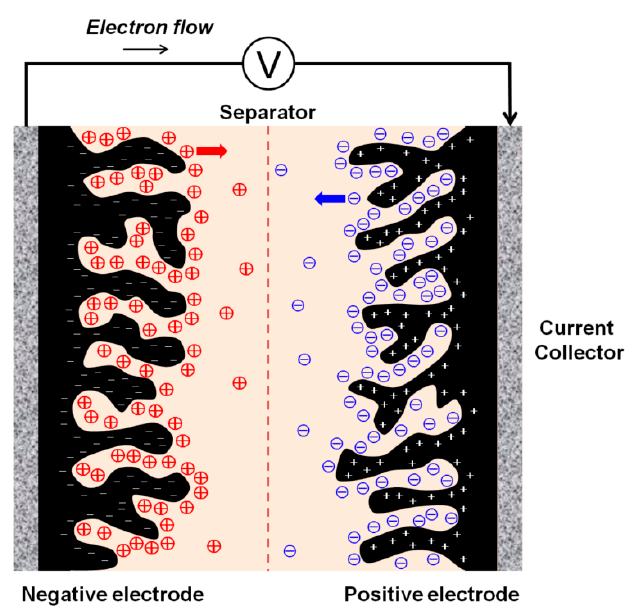
Scheme 2. A simplified view of the porous carbon-based supercapacitor to show operating principle of energy of energy storage.